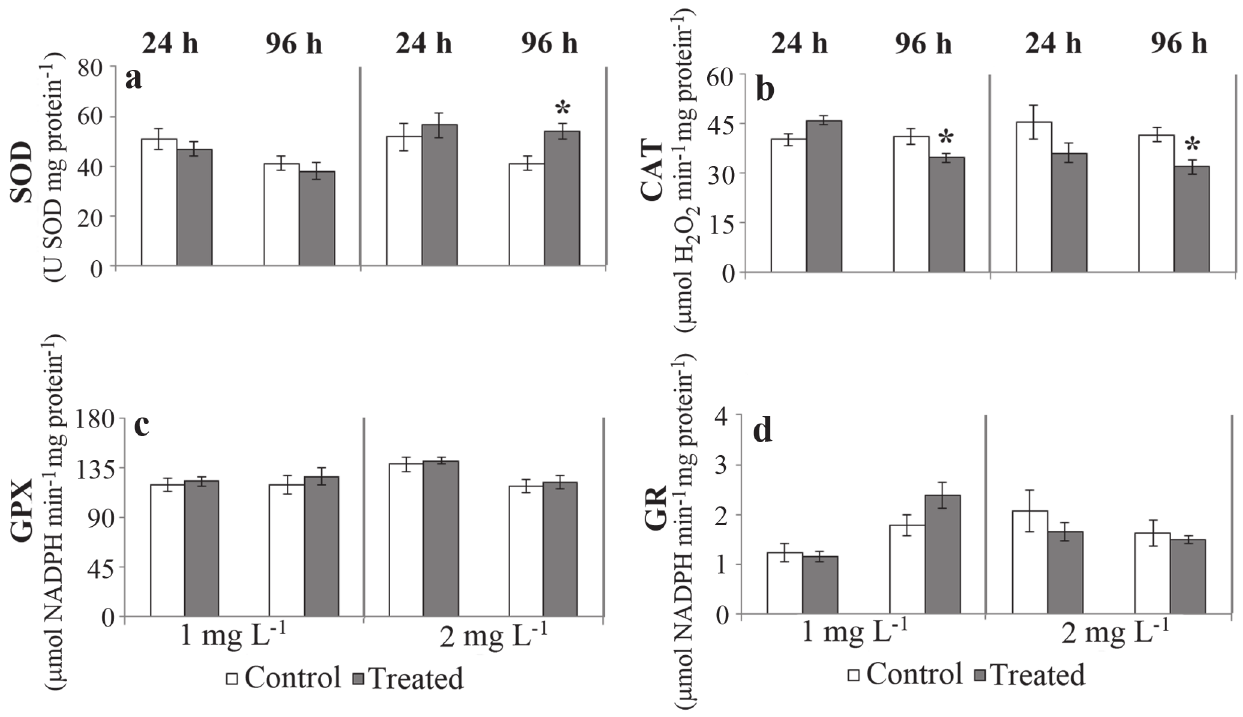
Fig. 4. Activity of superoxide dismutase (SOD; a ), catalase (CAT; b ), glutathione peroxidase (GPx; c ) and glutathione reductase (GR; d ) in liver of Prochilodus lineatus exposed to 1 or 2 mg L -1 lyophilized Microcystis aeruginosa (treated) or only water (control), for 24 and 96 h. Values are presented as mean ± SEM (n = 8). Asterisks indicate significant differences when compared to respective control (p <